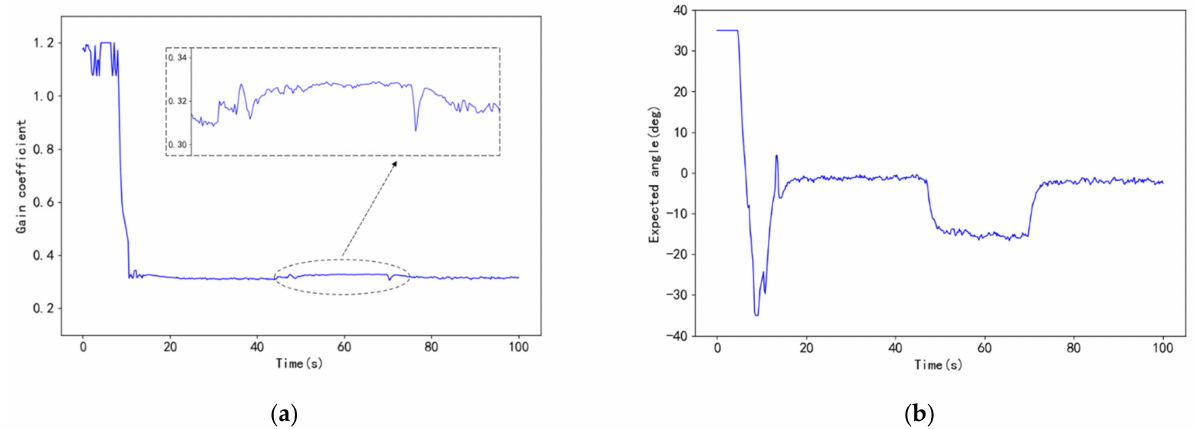
Figure 11. Parameters of the path tracking based on PSO-FSM. ( a ) Gain coefficient of the path tracking; ( b ) Expected steering angle of the path